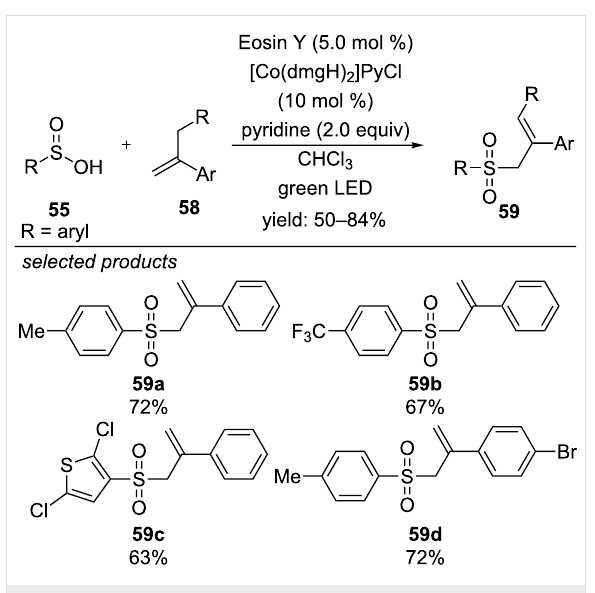
tion process. Increasing amounts of the photocatalyst increased the yield of product and H